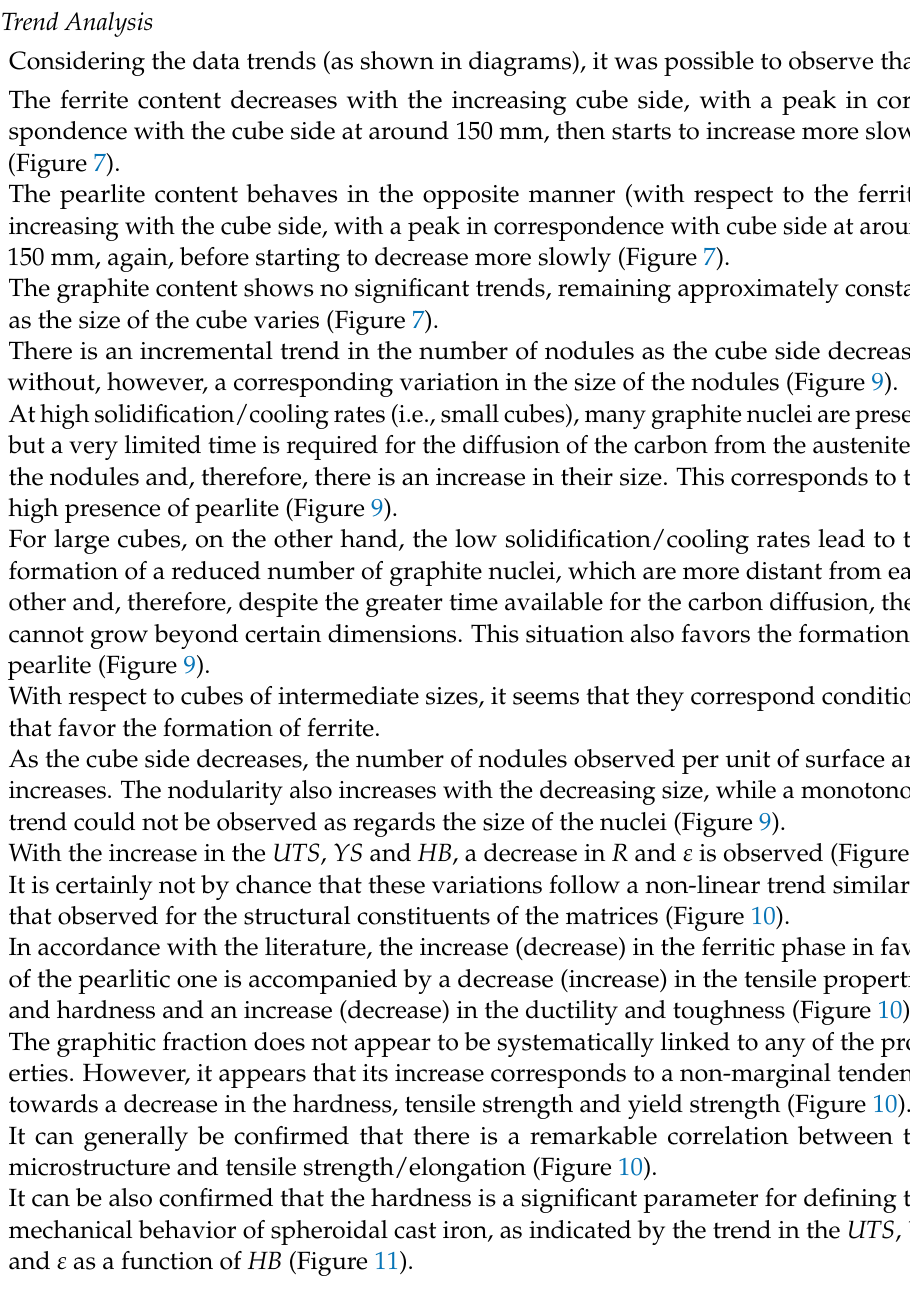
Figure 11. Tensile strength ( UTS ), yield strength ( YS ) and elongation ( ε ) as a function of the hardness (with red dots potential outliers).